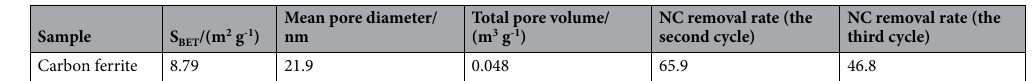
Table 1. Summary of the physicochemical properties and the reutilization of the synthesized carbon ferrite.